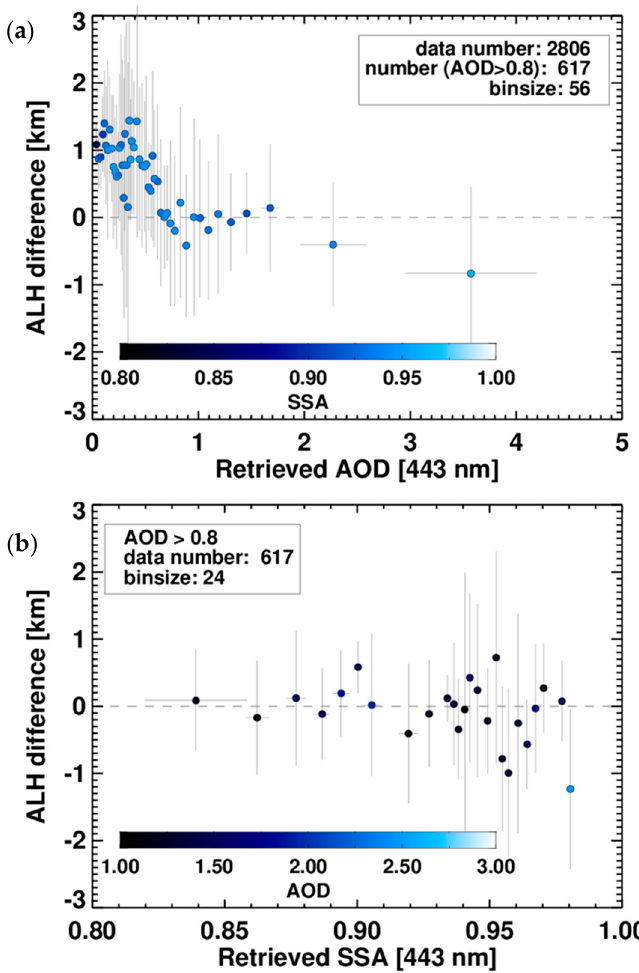
Figure 8. Difference between ALH retrieved from the developed algorithm and the attenuated-backscatter-weighted height estimated from the CALIOP 1064 nm product for the period from March to May 2007. The difference values are sorted by ( a ) AOD and ( b ) SSA and the bottom panel only includes values for AOD > 0.8. Standard deviations of the values sorted by each bin are shown by vertical and horizontal bars. Colors indicate mean ( a ) SSA and ( b ) AOD for each bin.